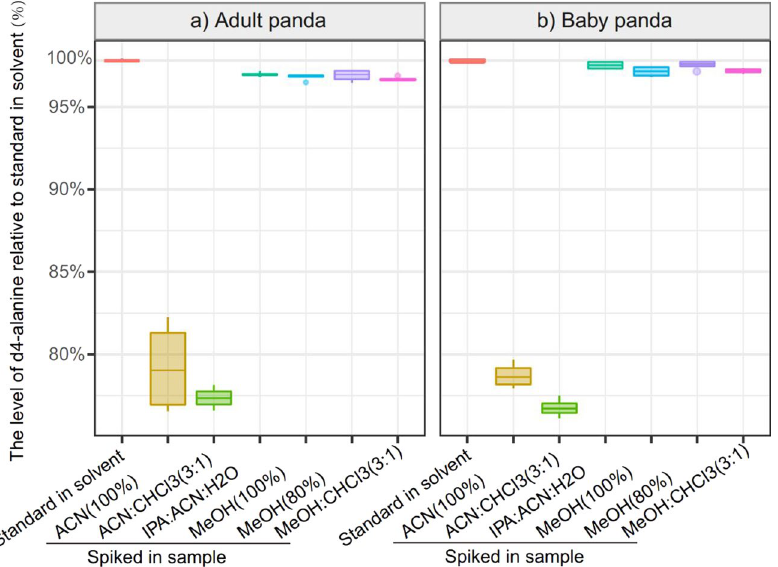
Figure 1. The extraction efficiency of d4-alanine in six different extraction solvents for adult ( a ) and baby ( b ) giant panda feces. d4-alanine was quantified after being spiked directly into the derivatisation chemical (standard in solvent) and levels were compared to d4-alanine levels in the feces samples following different extraction methods (black horizontal lines). The values of d4-alanine were adjusted relative to the levels in the standard in solvent (set to 100%). Four experimental replicates were measured for each extraction method. The distributions of the boxplots are minimum, 25 th percentile, median, 75 th percentile, and maximum (from bottom to top direction). Dots are outliers (above or below the median by more than 1.5 times the interquartile